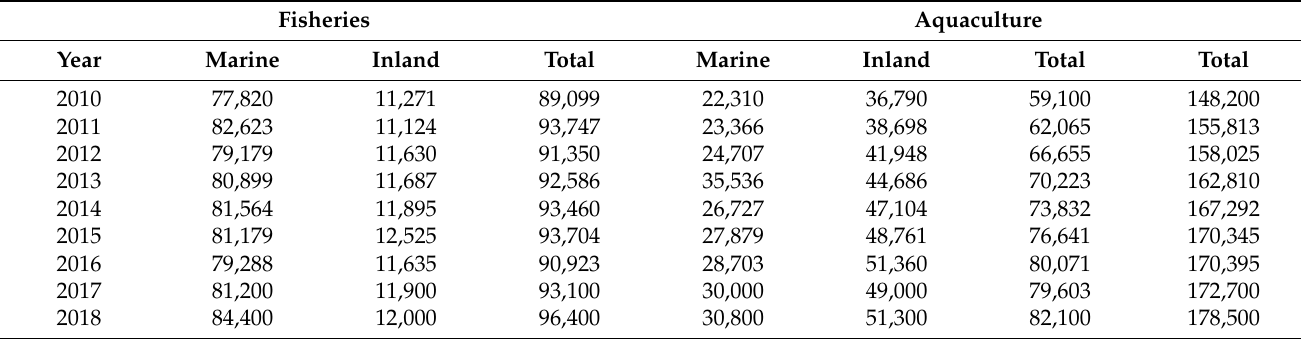
Table 2. World fisheries and aquaculture production ( × 1000